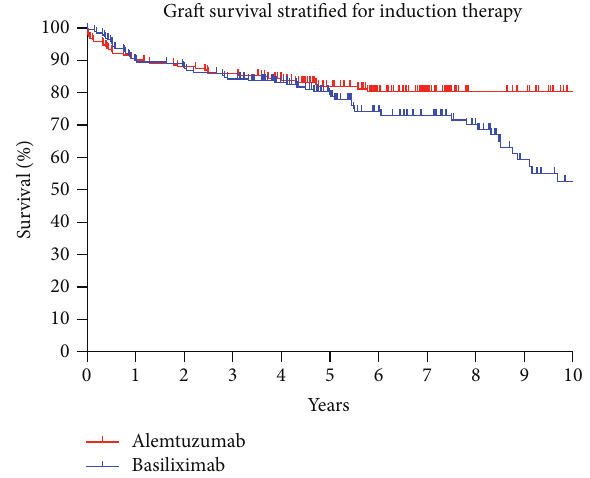
Figure 1: Graft survival after 1, 5, and 10 years was 90.16%, 81.94%, and 80.36% in the alemtuzumab group versus 89.52%, 78.52%, and 52.66% for KTx recipients who received basiliximab; 𝑝 = 0.076 .